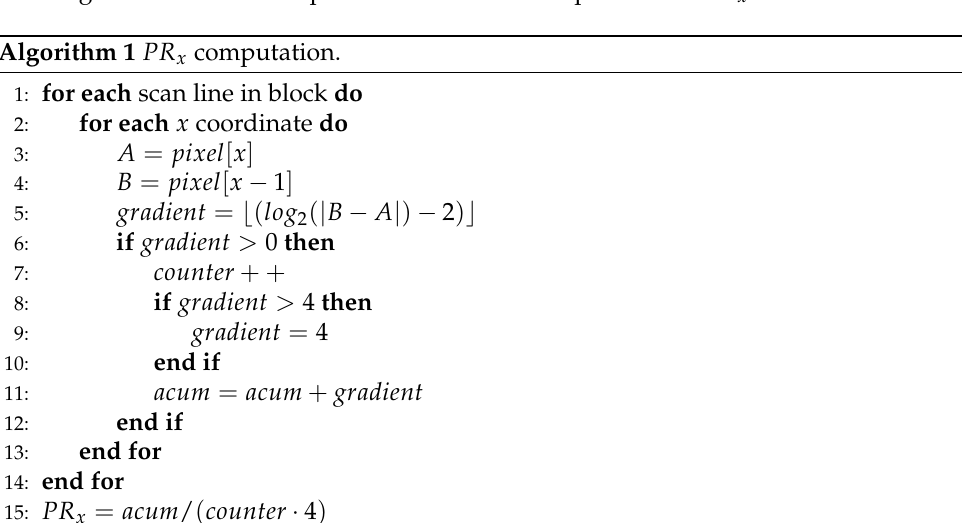
Figure 4. PR x computation using all scanlines vs. using a subset. Algorithm 1 shows the pseudocode for the computation of PR x